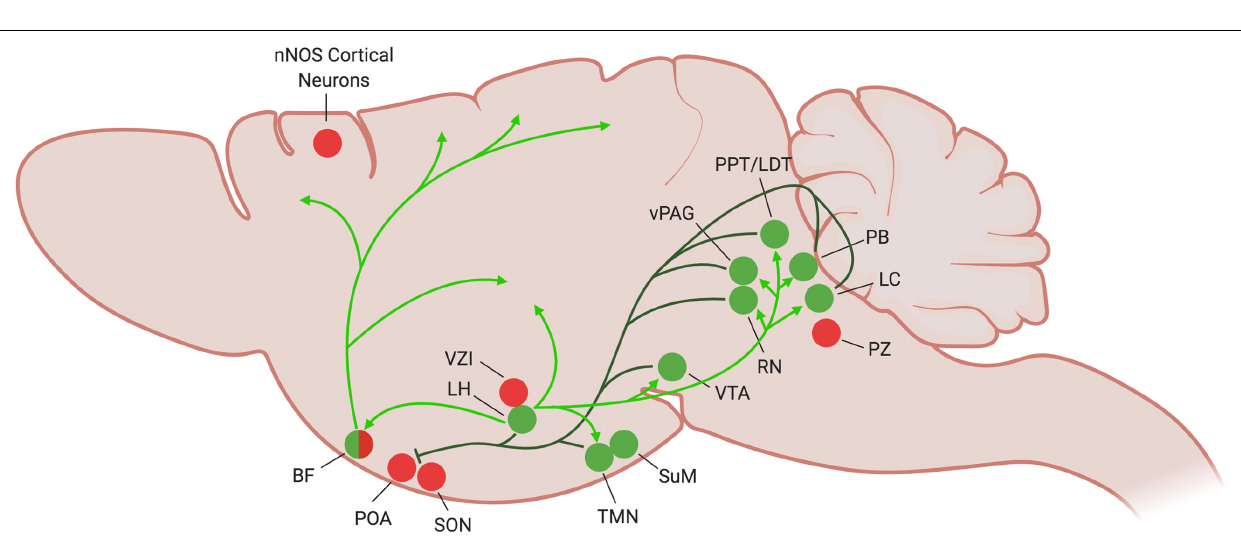
FIGURE 1 | Current understanding of NREM sleep circuitry in the mouse brain. At the onset of NREM sleep, sleep-promoting neurons (red circles) become active and inhibit many of the wake-promoting nuclei of the brain (green circles) to reinforce and stabilize the sleep state. Figure created with BioRender.com.